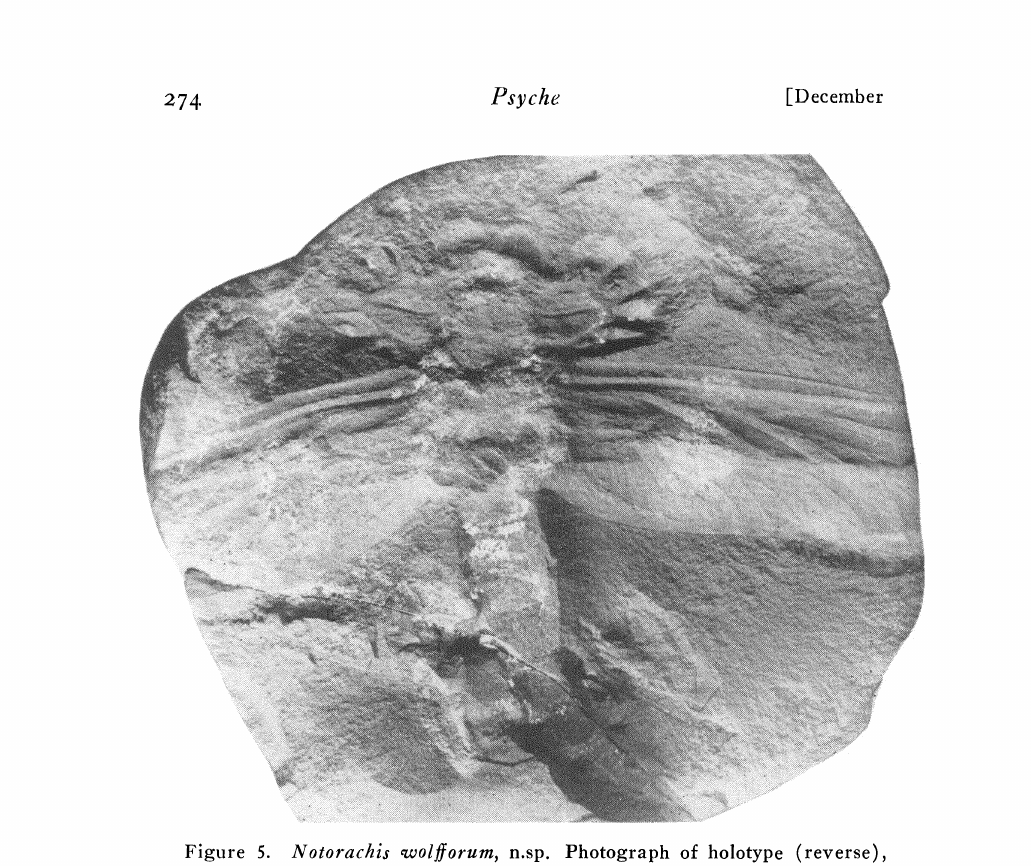
Figure 5. Notorachis wolfforum, n.sp. Photograph of holotype (reverse), showing overlapping of wings and the general form of the